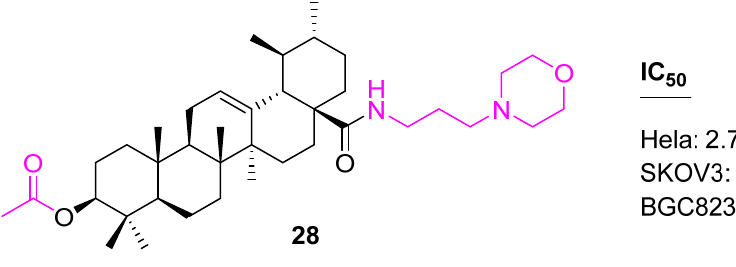
Figure 18. Structure of 28 .